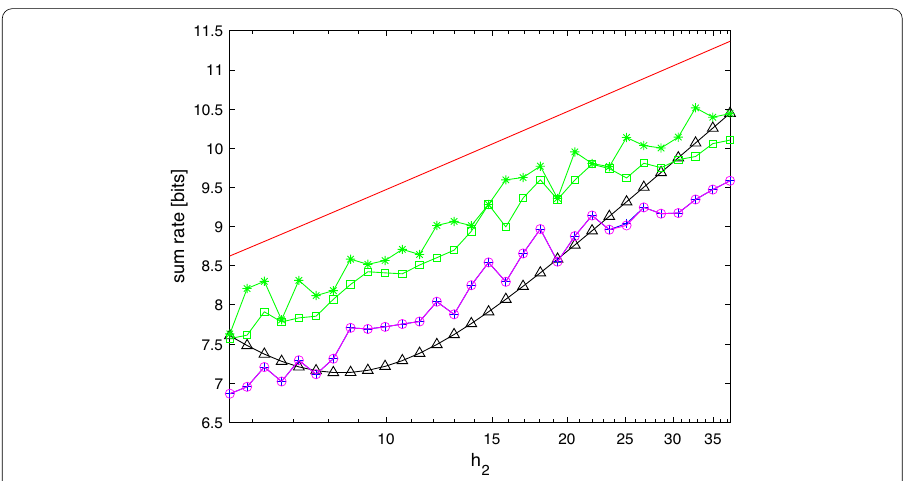
1 . The top curve ‘red 37 dB and h 1 = = h 2 1 P 1 h 2 2 P . The markers ‘green asterisk’ and ‘blue plus’ N + N + (cid:30) (cid:31)